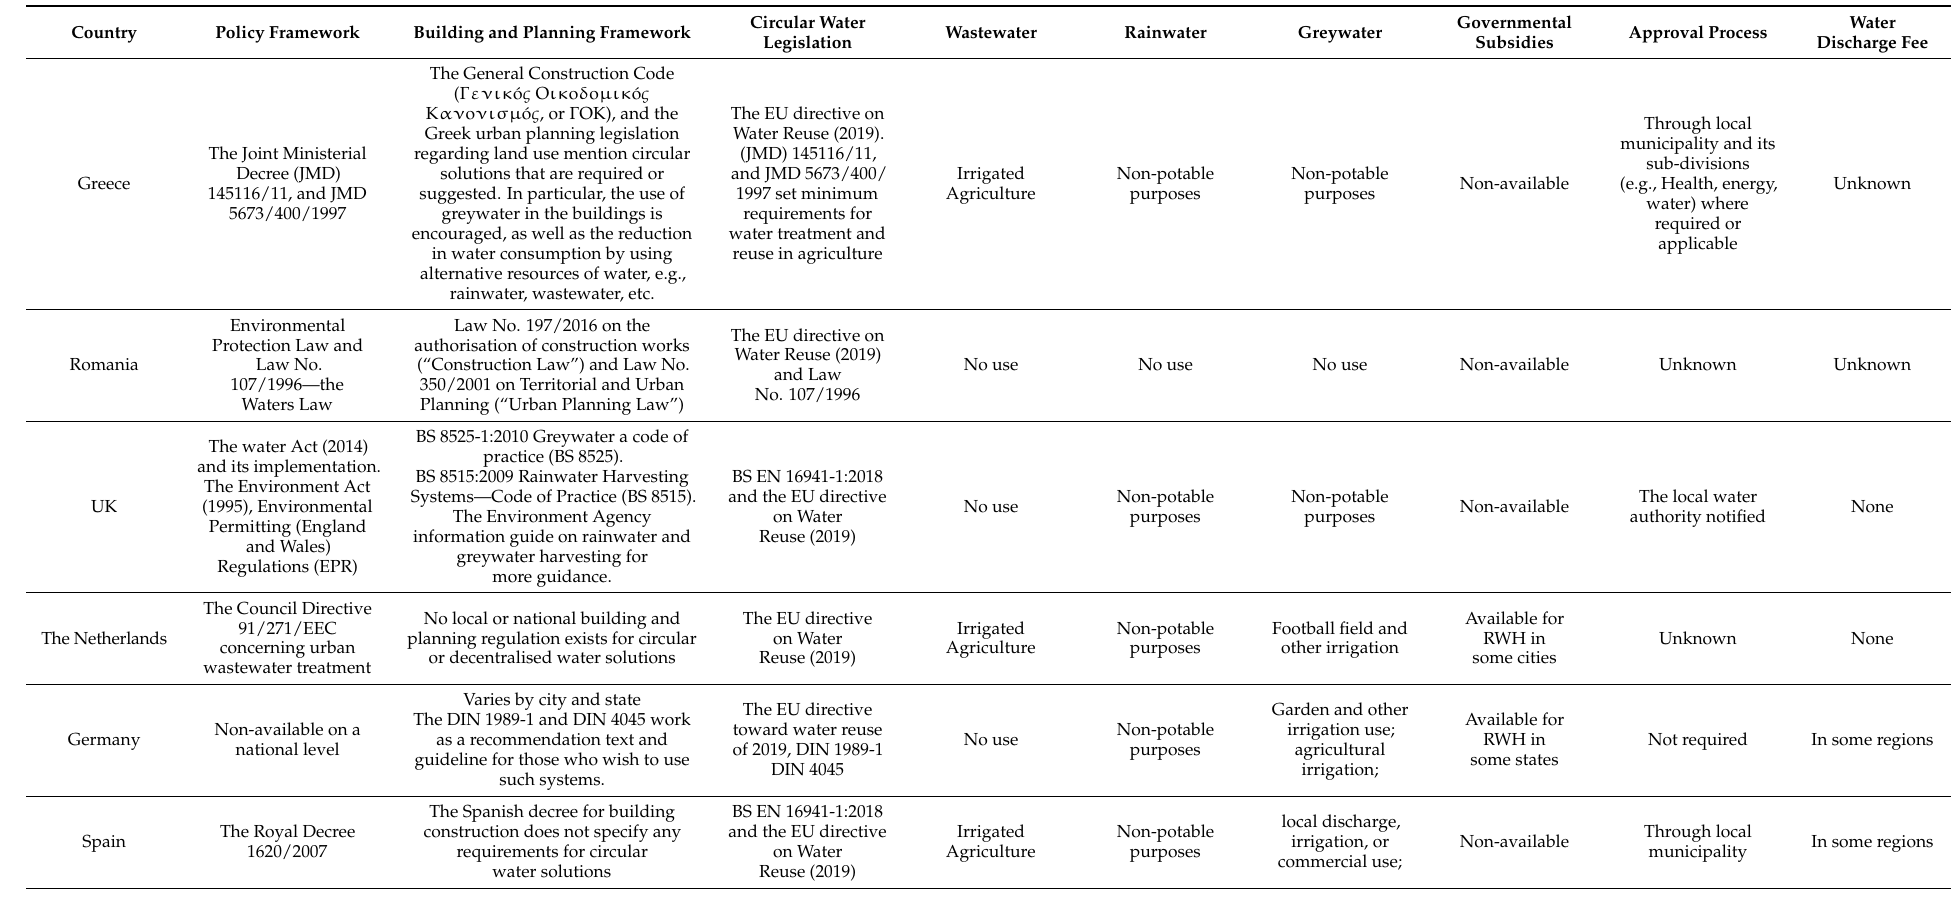
Table 4. State-of-the-art regulatory and legal framework for circular water solutions in case study EU